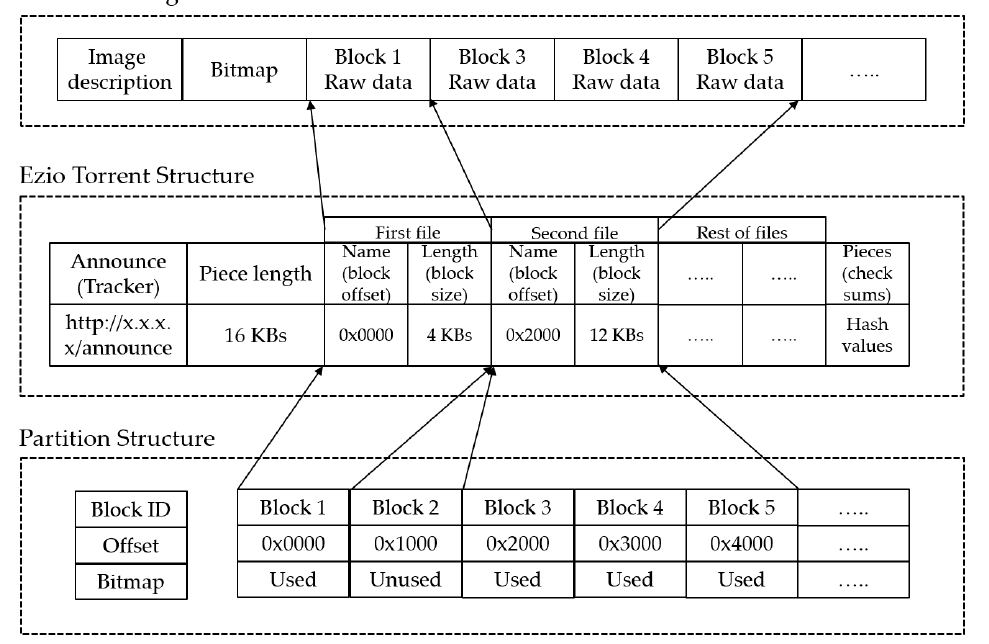
Figure 5. The image format for the proposed FSBT mechanism in this study.